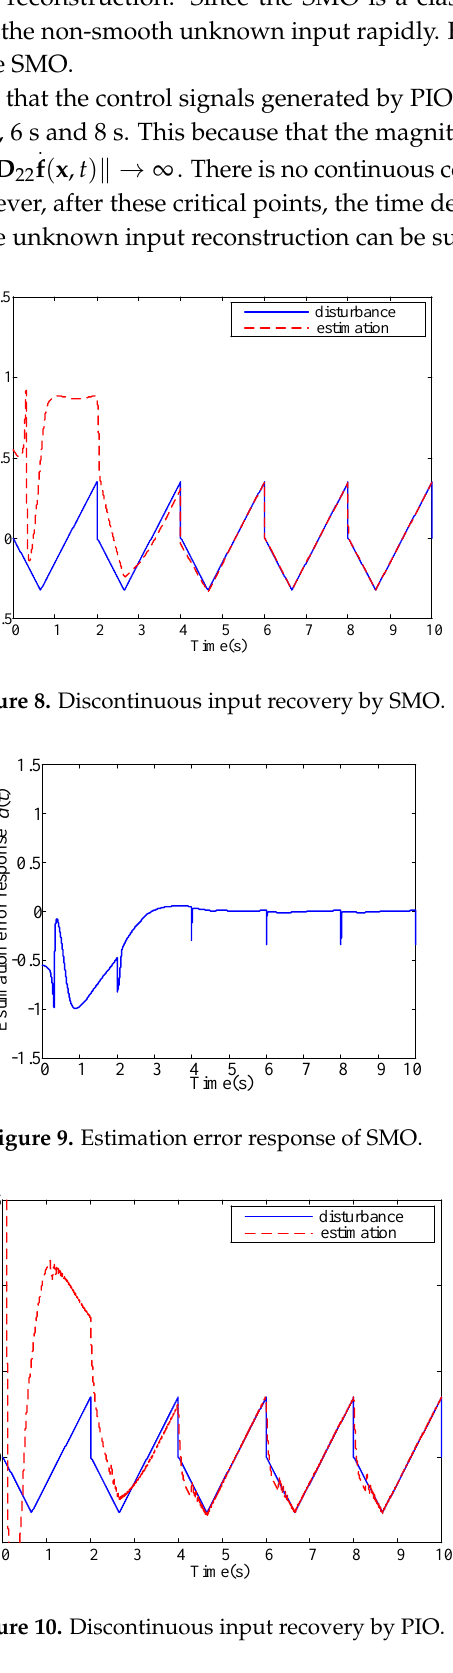
Figure 10. Discontinuous input recovery by PIO.